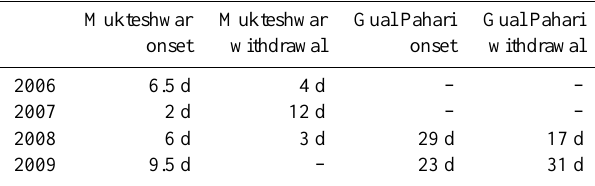
Table 3. Characteristic transition times for the monsoon season onset and withdrawal according to aerosol concentration changes. See text for